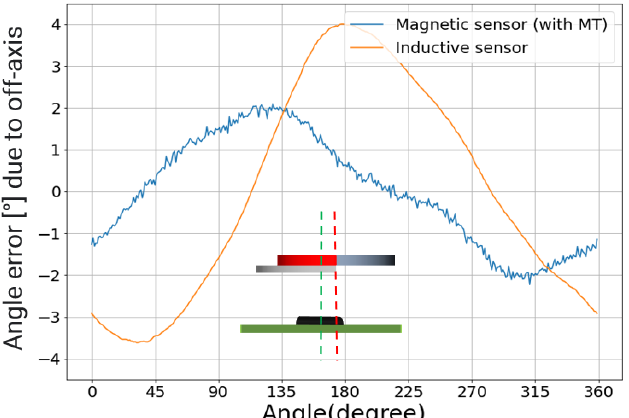
Figure 9. Angle error curves due to 1 mm of off-axis shift of the target. The impact is twice as large on the inductive sensor. The inset depicts the configuration. The dotted green line is the center line through the sensor center. The dotted red line is the center line through the target